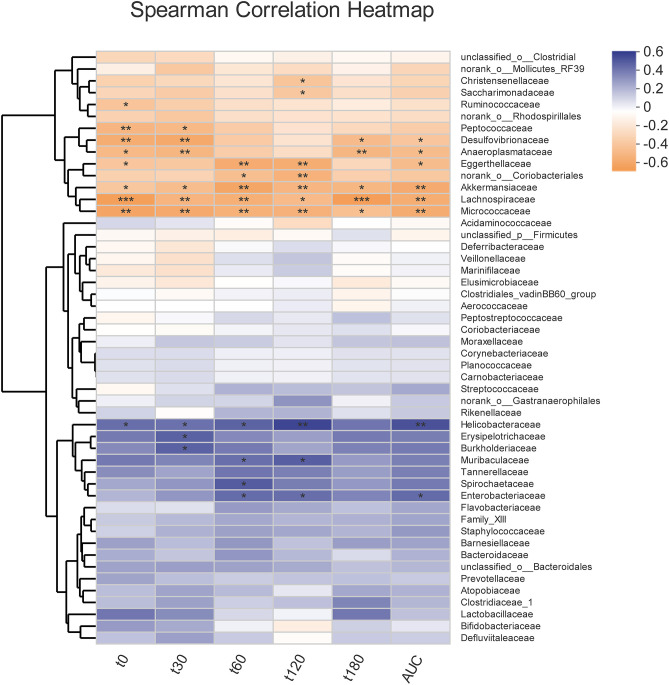
Correlation heatmap of the fecal microbiota with blood glucose indexes. Spearman correlation analysis between the top 50 most abundant bacterial families and blood glucose levels during intragastric glucose tolerance test. *P < 0.05, **P ≤ 0.01, ***P ≤ 0.001.